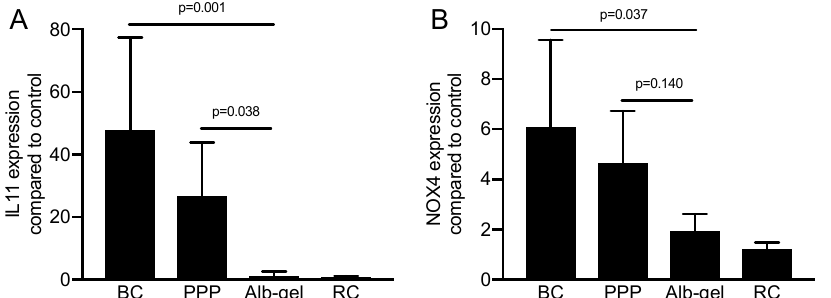
Figure 1. Platelet-poor plasma (PPP) and buffy coat but not heated PPP induced a substantial increase in TGF-ß target genes. Gingival fibroblasts were exposed to 30% of the respective lysates prepared from PPP, heated PPP (75 °C for 10 min; Alb-gel), and buffy coat (BC). For red clot (RC), 5% of the lysates was used. Expression analysis of ( A ) IL11 and ( B ) NOX4 was expressed as x-fold increases compared to the basal levels of untreated cells. Bar graphs show the means and standard deviation of four independent experiments (N = 4). Statistical analysis was based on an ANOVA with a multiple comparison against heated PPP based on Fischer’s LSD test.